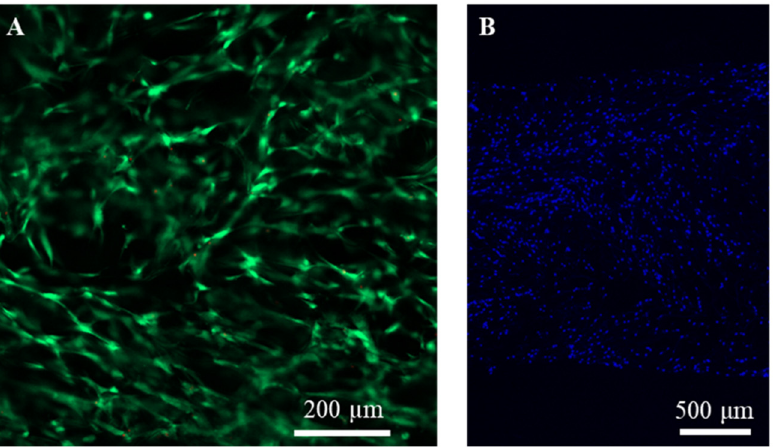
Figure 2. Fluorescence photomicrographs of ( A ) live/dead staining and ( B ) nuclear staining of hMSCs after culture in collagen sponges for 1 day. Green fluorescence indicates live cells, while red fluorescence indicates dead cells. Blue fluorescent dots indicate the stained nuclei.